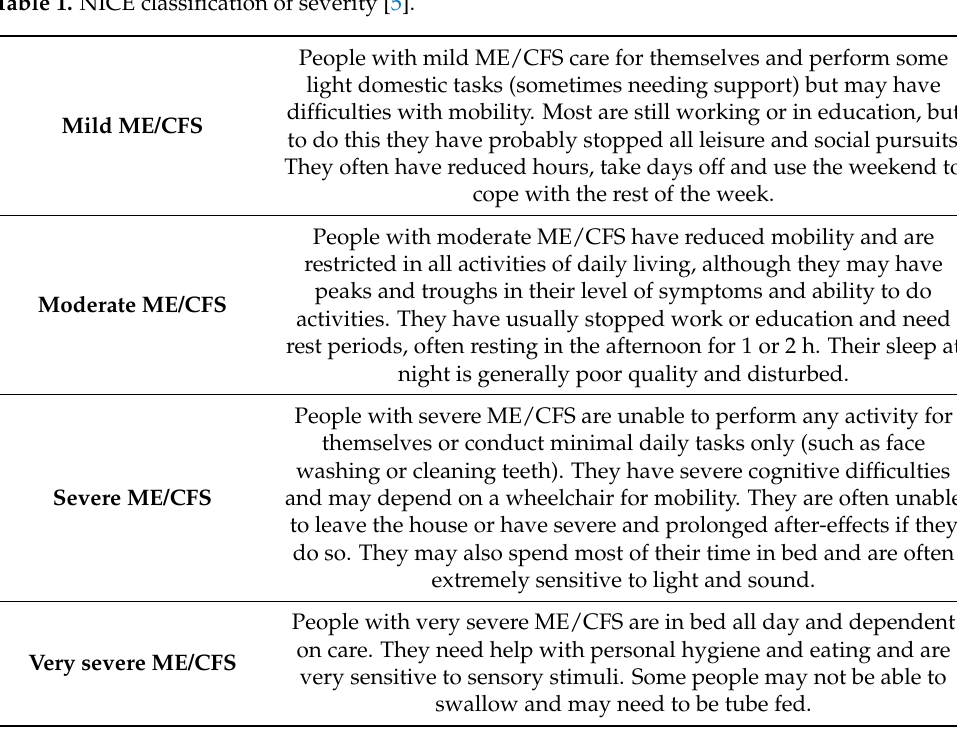
Table 1. NICE classification of severity